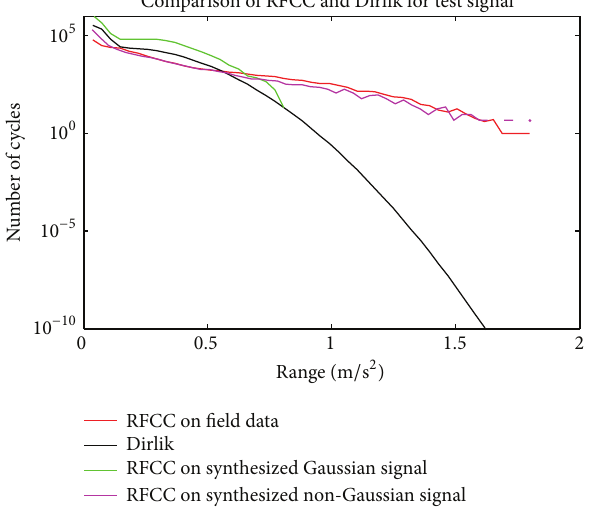
Figure 12: Time history of field data and synthesized data.